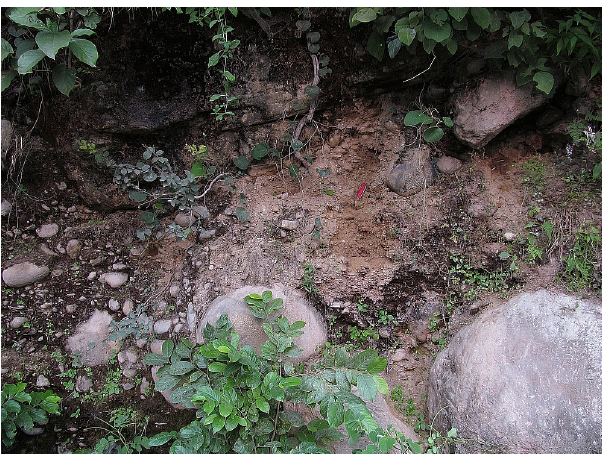
Figure A13. NGT – 4m high exposure of low angle cross-bedded sands, topped with finer silt and mud deposits, corresponding to OSL sample from this part of unit dated at 7200 ± 2000 years by Sinha et al. (2010).